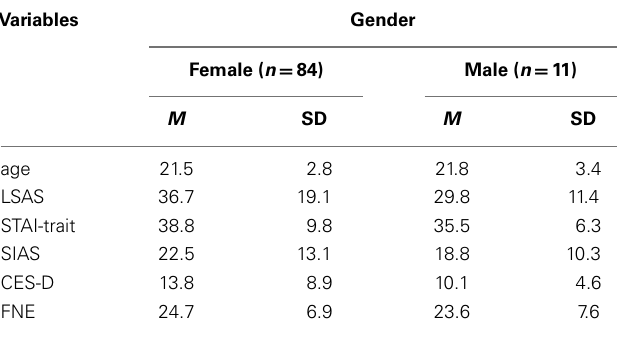
Table 3 | Mean difference scores ( M Diff ), standard errors (SE), and p -values for each pairwise comparison of crowd